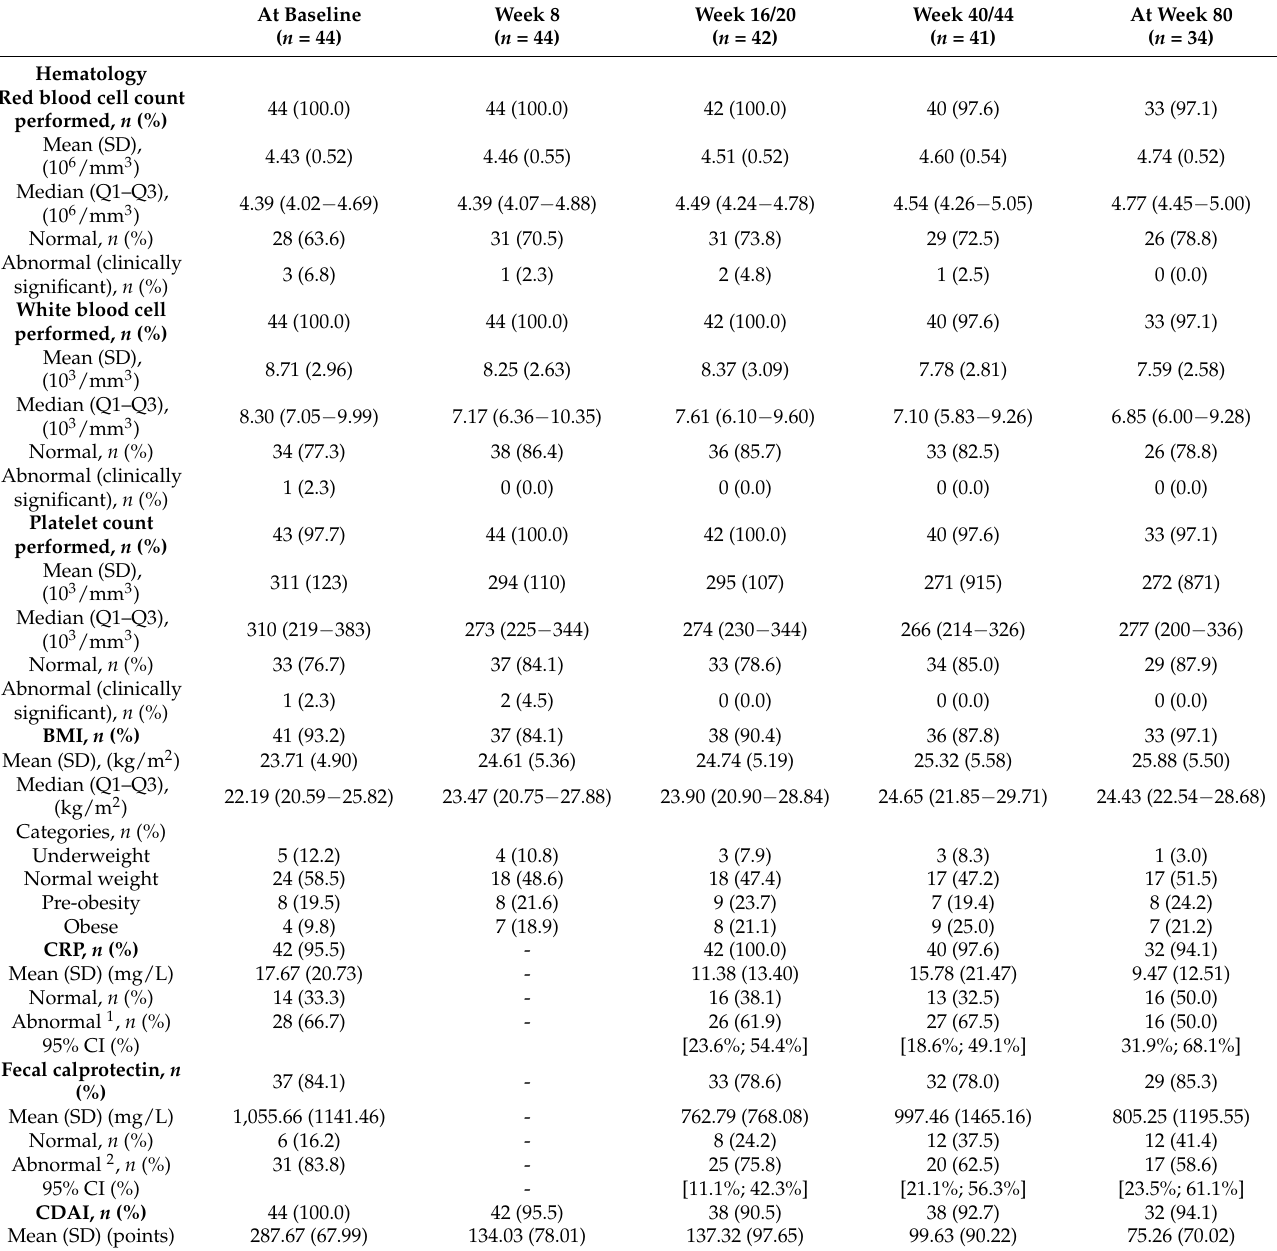
Table 3. Laboratorial measurements and clinical